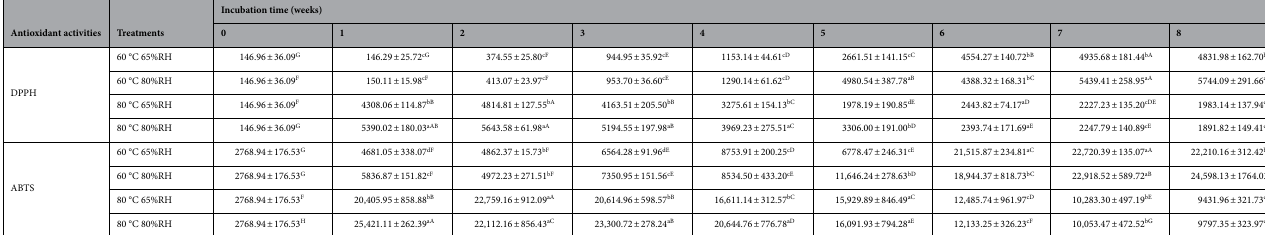
Table 2. Antioxidant activities of black garlic prepared using soaking followed by freezing pre-treatment methods at various temperatures and relative humidities. a–d Different superscripts within the same column indicate significant differences of each colour parameter compared for the same incubation time ( p ≤ 0.05). A–G Different superscripts within the same row indicate significant differences ( p ≤ 0.05).